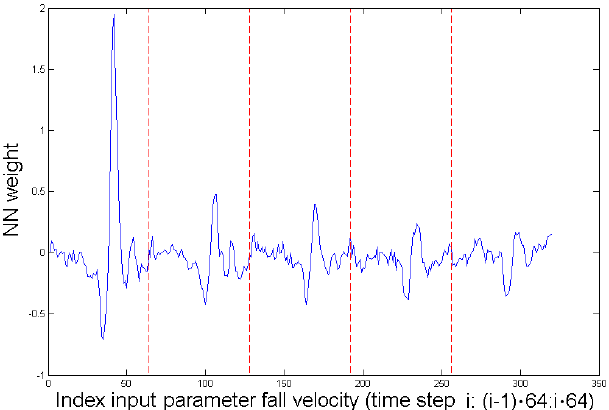
Figure 3. Fall velocity weights for node 22 of the input layer.